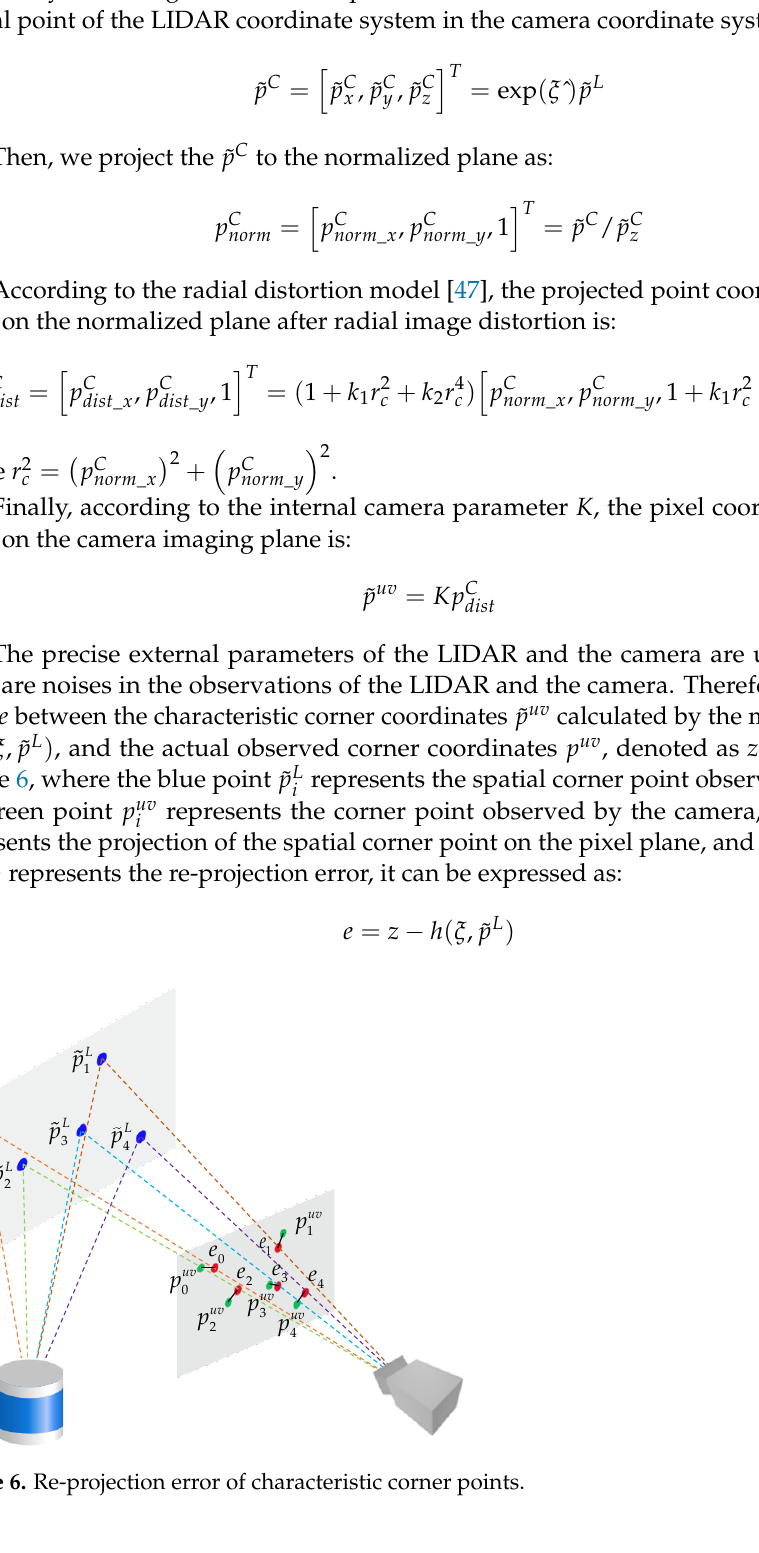
Solving this least-squares problem, the external parameter  and the spatial posi- tion